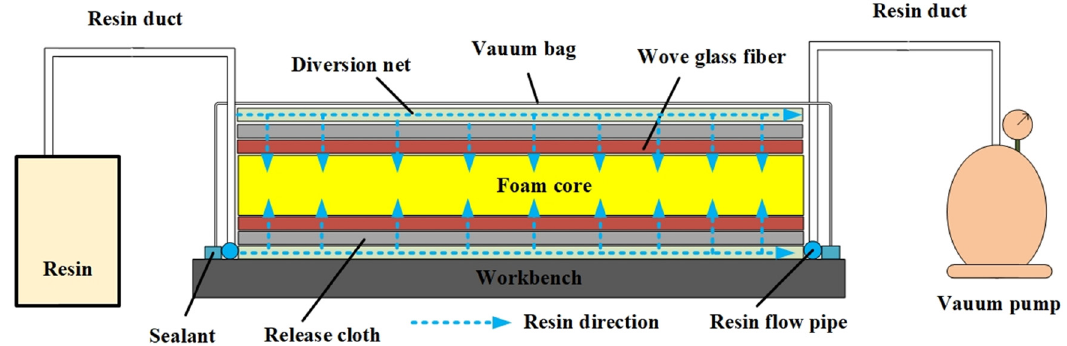
Figure 1: Sandwich panels manufactured by the VARI